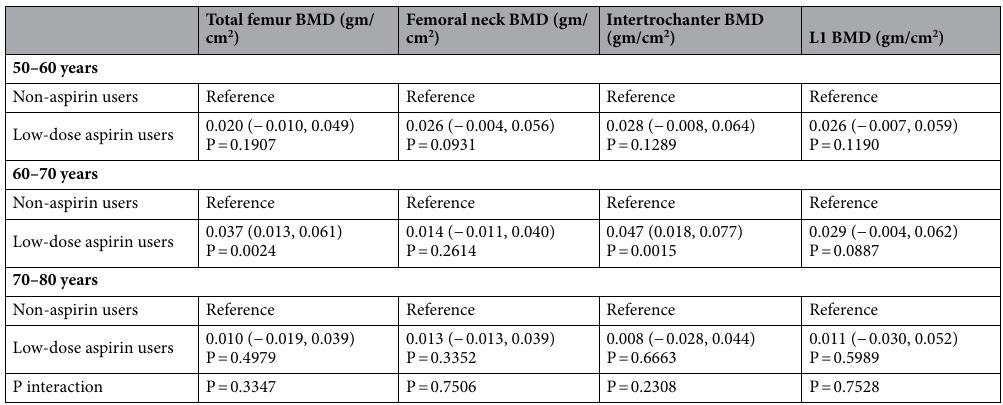
Table 5 shows the results of multiple regression analysis. In the unadjusted model 1, low-dose aspirin use was positively associated with bone mineral density (Total femur BMD β = 0.021, 95% CI 0.001–0.041; Femoral neck